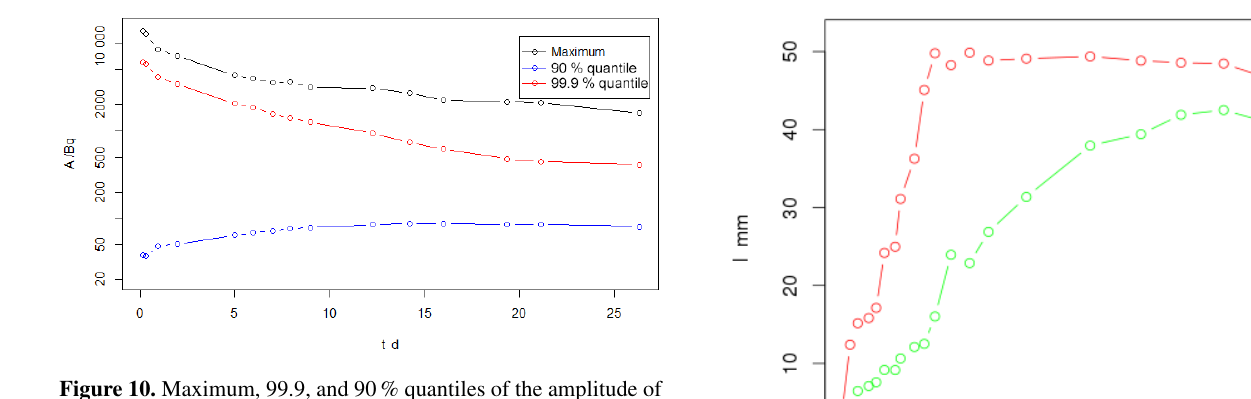
cation of the FWHM line (full width half maximum). From Fig. 11 we read a propagation velocity of 0.5 and 2 mm d −